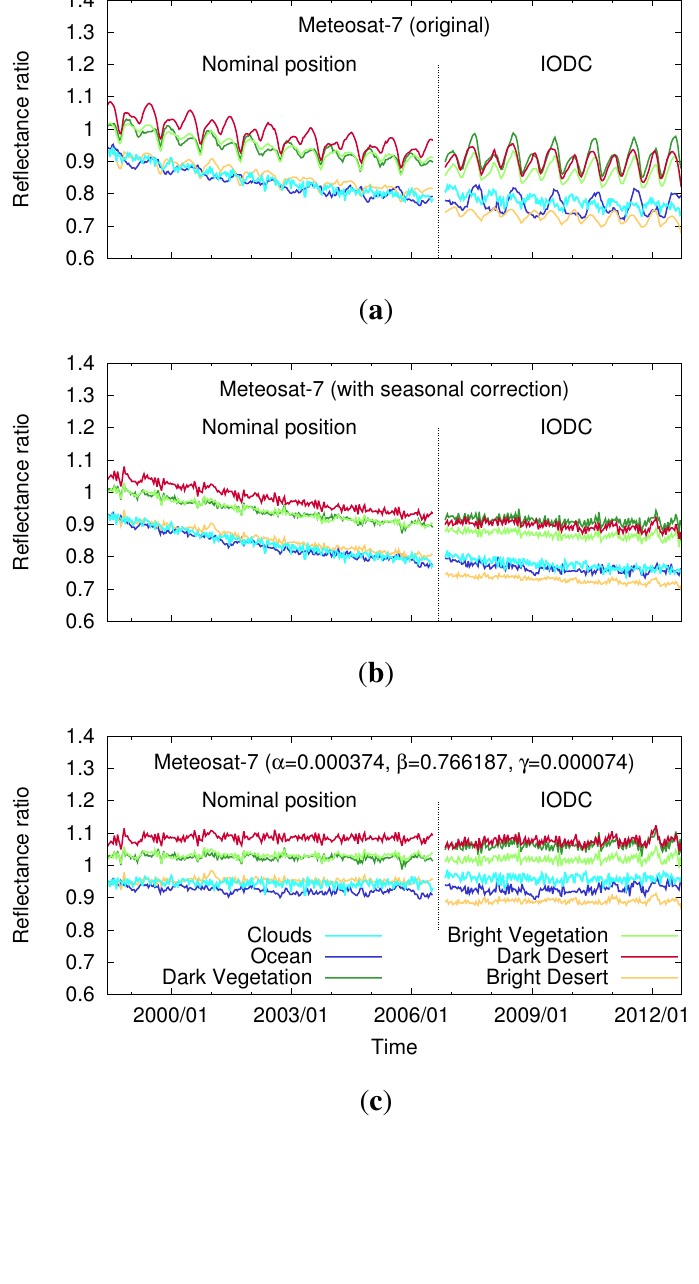
Figure 18. Meteosat-7 IODC time series for the data coverage at 0 ◦ longitude, and the IODC at 57 ◦ E for ( a ) the original; ( b ) the seasonal corrected; and ( c ) the aging corrected time